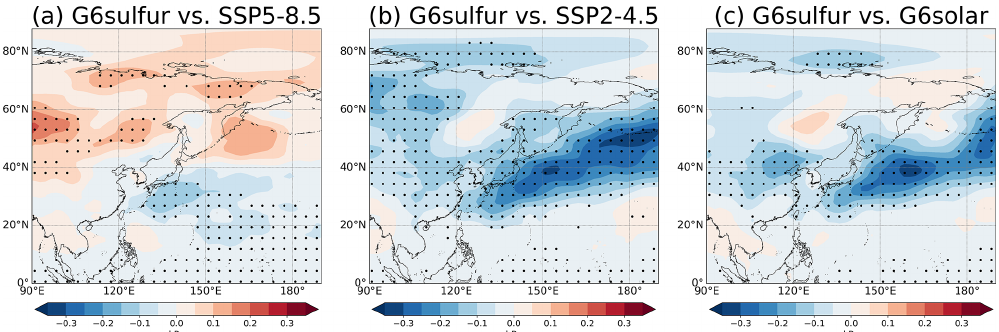
Figure 6. As in Fig. 5 but for the root mean square of 2–6d bandpass-filtered MSLP (proxy for eddy kinetic energy and storm tracks; unit in hPa) during MJJAS. Stippling indicates changes that are statistically significant ( p value < 0.05 based on Student’s t test).